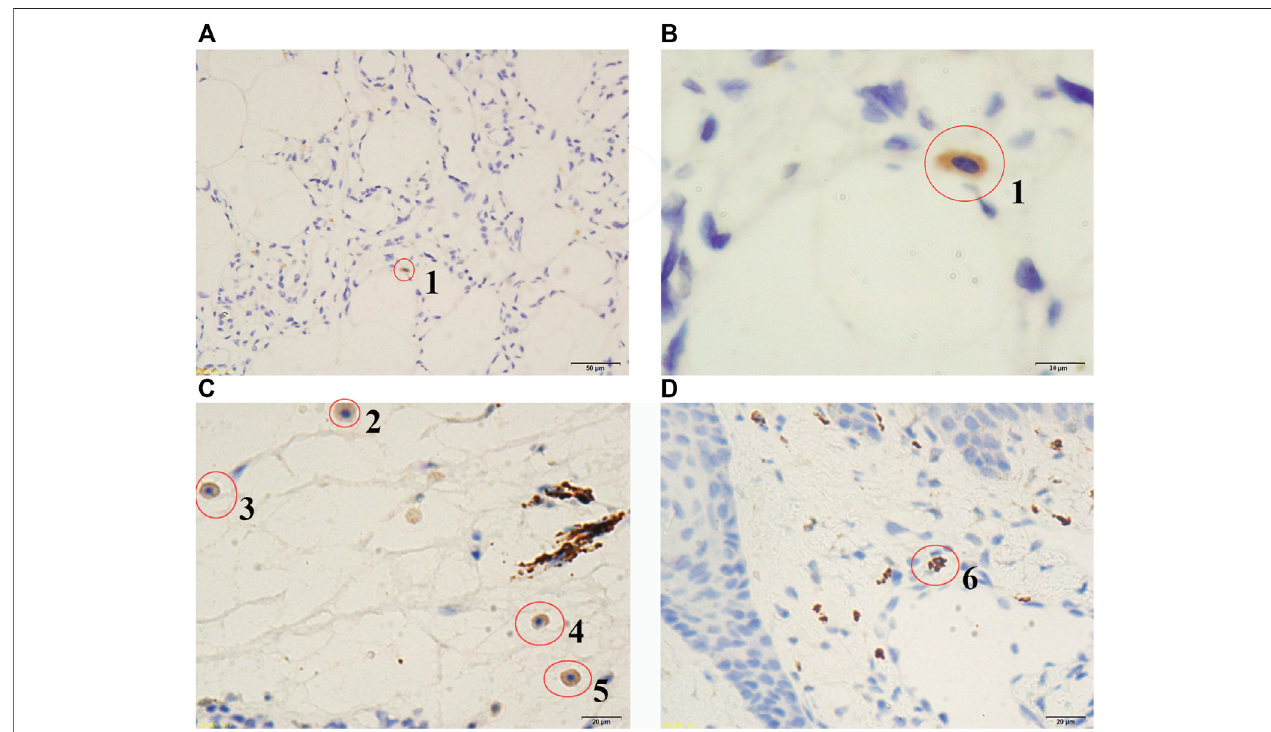
FIGURE 3 | Stained embryonic MSCs at different apoptosis stages. Red circles were used to indicate the cells stained by immunohistochemistry (IHC) technique. According to the nuclear sizes, the stained cells were numbered from 1 to 6, which are embryonic mesenchymal stem cells (MSCs) at different apoptosis stages. The larger the stained nuclear size is, the earlier the apoptosis stage is. Microscopes with ordinary lens (A) and oil immersion lens (B) were used to observe tumour tissue of the patient (Admission number: 1097108). Microscopes with ordinary lens (C and D) were used to observe tumour tissues of the patients (Admission numbers: 1089641 and 1082186). The patient information (Admission number: 1097108, 1089641 and 1082186) can be seen in the Supplementary File S1 .